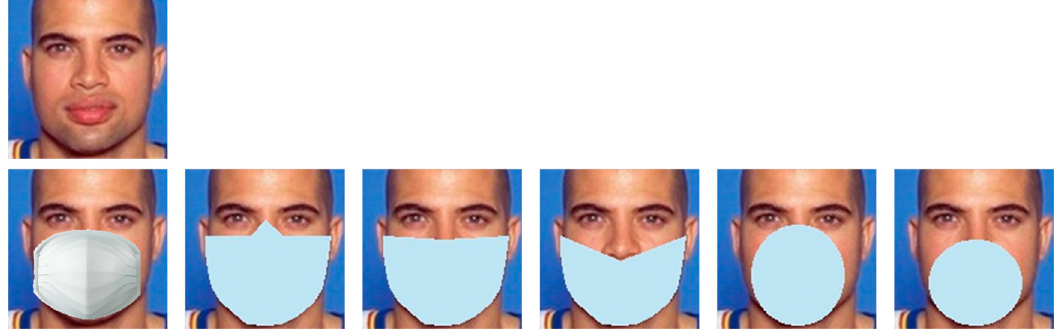
Figure 4. Artificially generated mask images.